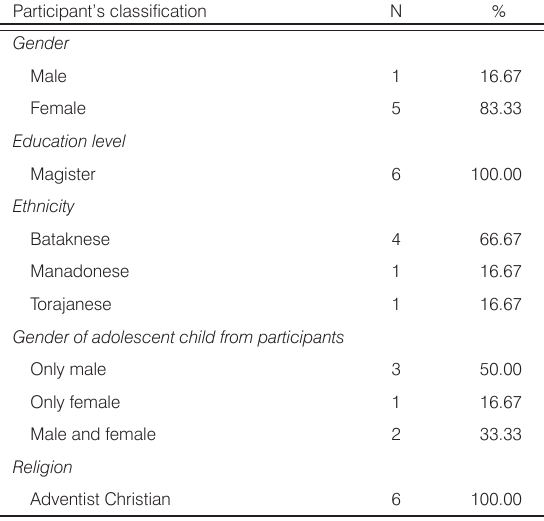
Table 1. Demographic data of